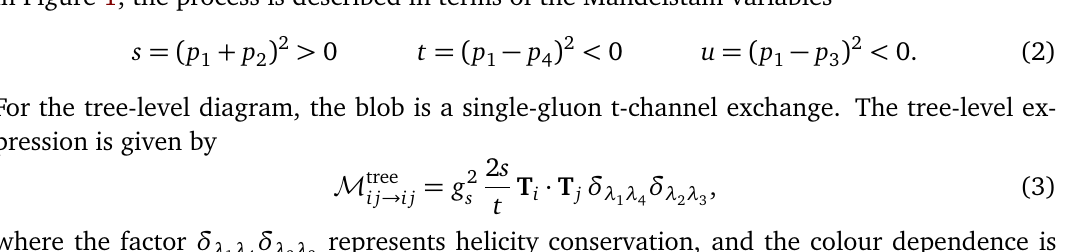
Figure 1: 2 to 2 particle scattering which at tree level correspond to eq. (3). The arrows indicate the direction of the momenta. The colour indices are a labels λ represent the particle k